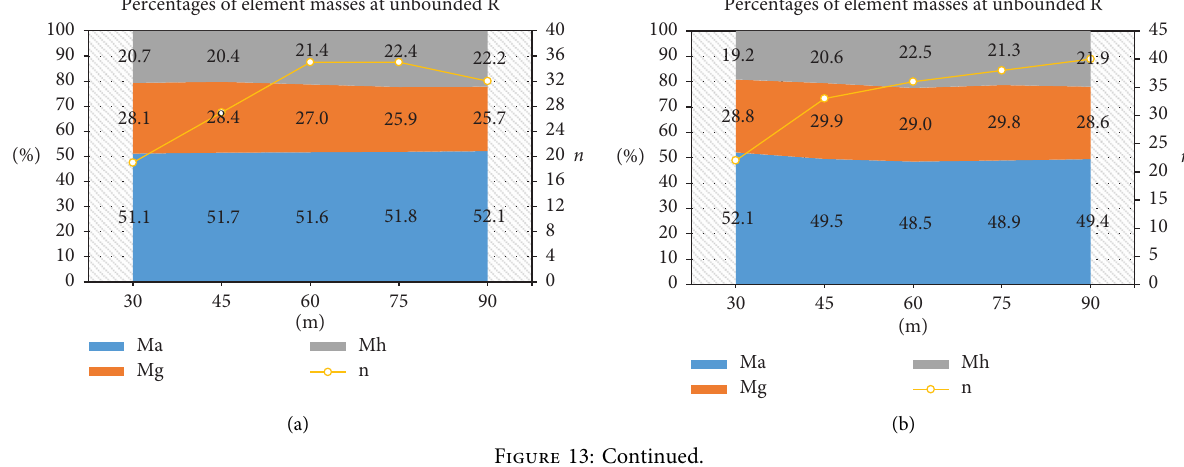
Percentages of element masses at unbounded